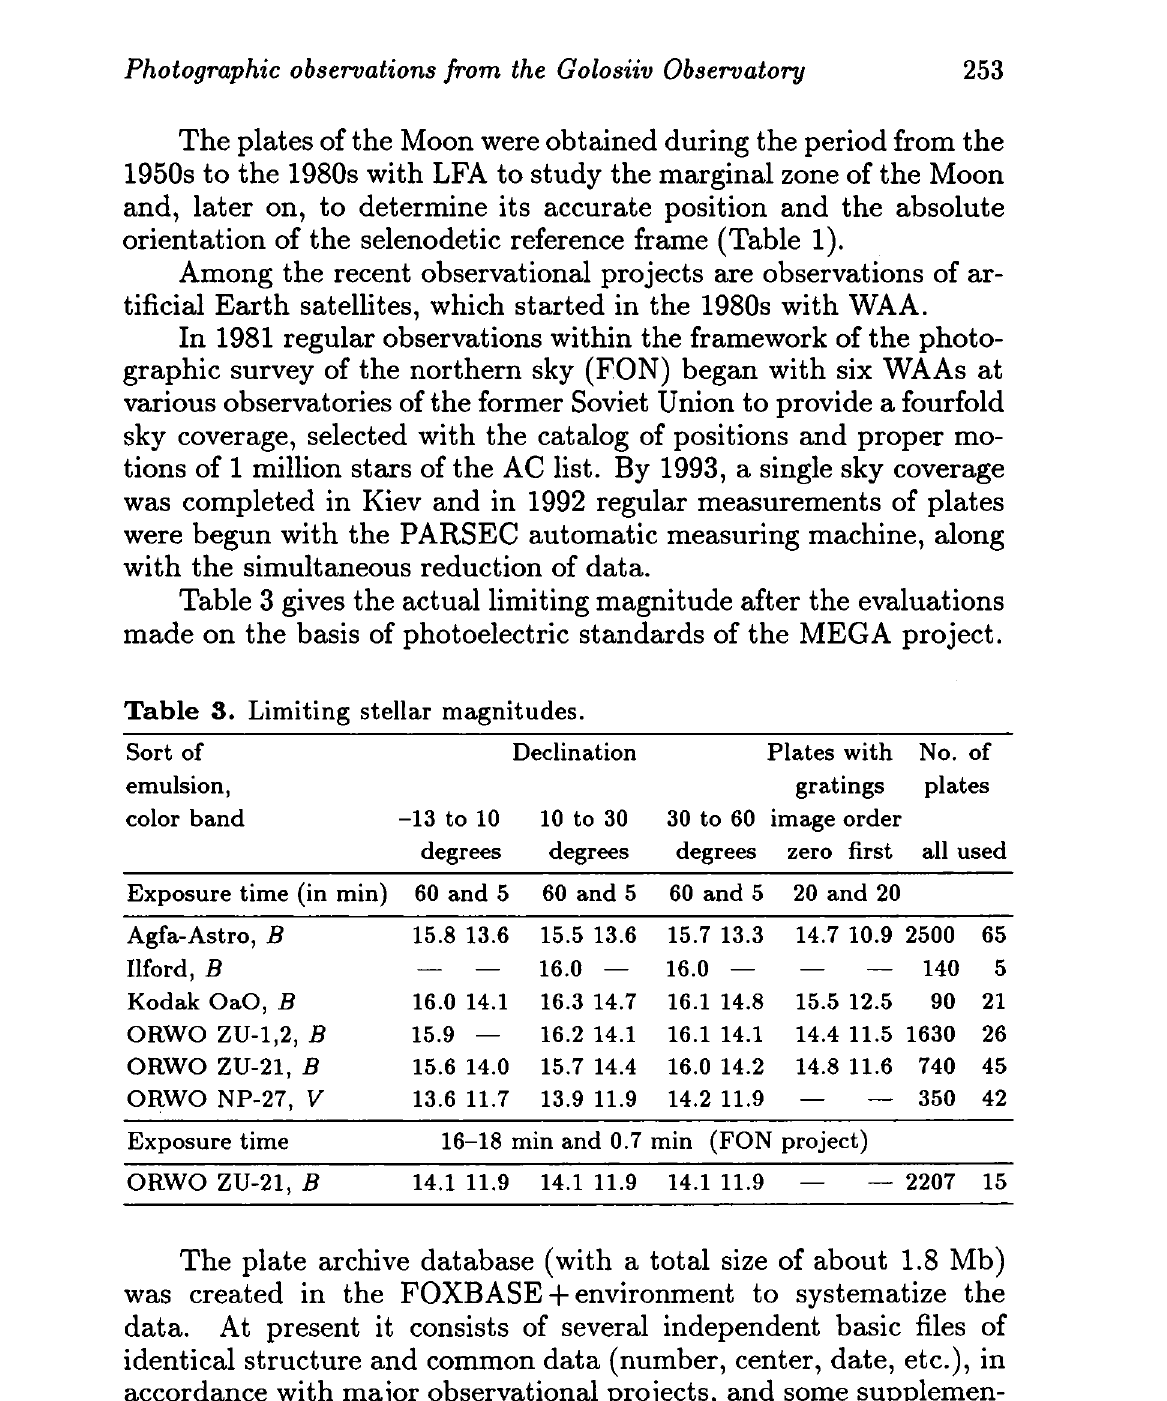
Table 3. Limiting stellar magnitudes. Sort of Declination Plates with No. of